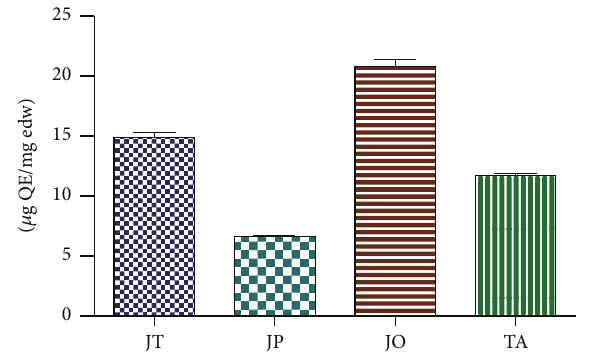
Figure 2: Total flavonoid content expressed as quercetin equivalents ( 𝜇 gQE)/mg plant extract in J. thurifera (JT), J. oxycedrus (JO), J. phoenicea (JP), and T. articulata (TA) infusions. Data are expressed as mean ± SD ( n = 3).